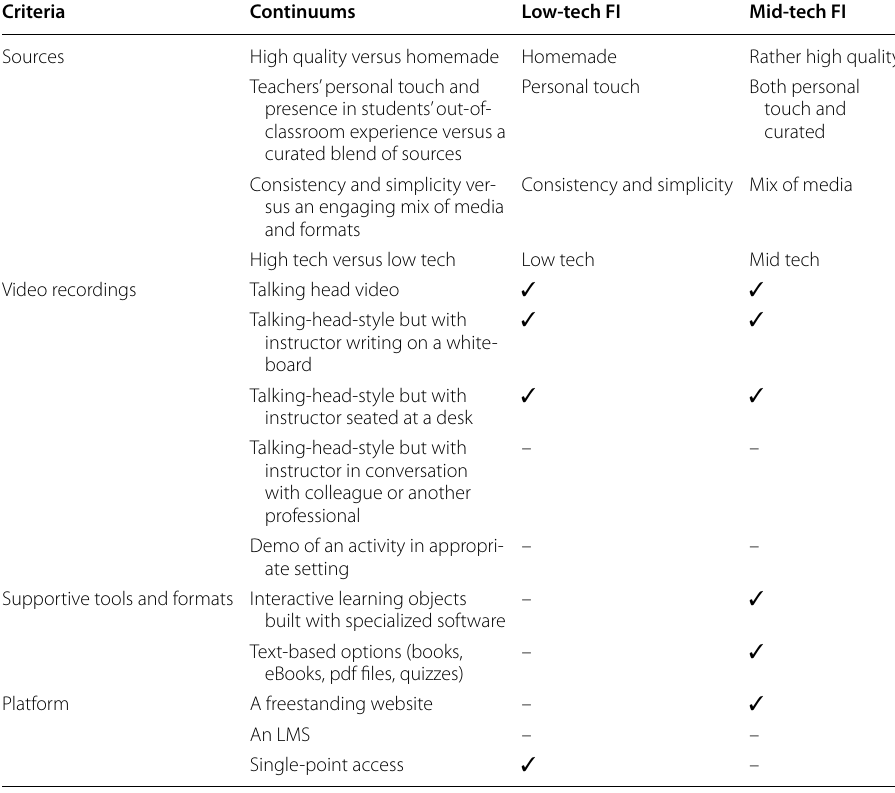
Table 3 Instructional materials for the flipped classes (based on Brown, 2018 )